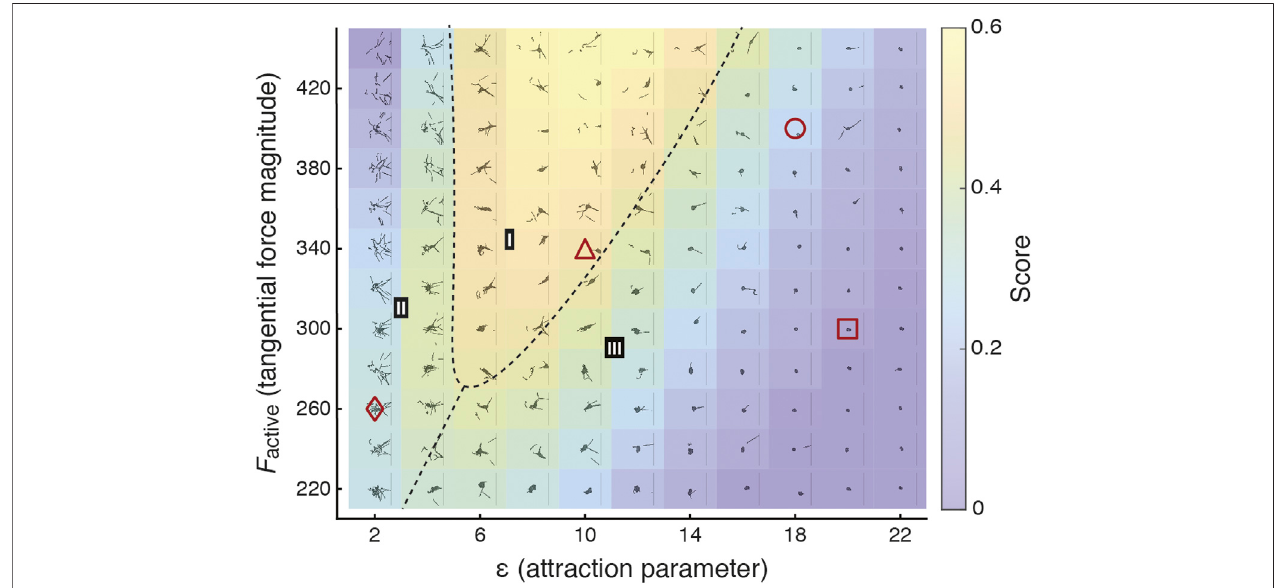
FIGURE5| Heatmapofscorerevealsparameter regimeinwhichthemosteffective collective locomotionisobserved. Thescoreillustratedin Figure4F is fi ttothe function given in Eq. 8 . The heatmap illustrates this fi tted score function and is divided into three regimes (I-III). I: consistently successful cohesive blob locomotion, re fl ectingobservedemergentlocomotioninrealwormblobs( Figure4A );II:generallyunsuccessfulbloblocomotion,withfailureduetodissociationofblobs;III:generally unsuccessful blob locomotion, with failure due to overly strong attachment, resulting in little collective movement. In phases II and III, parameter combinations near theboundaryofphase Icanintermittentlyleadtosuccessful collective locomotion. Eachsubpanel showsanoverlaidsnapshotat between t (cid:1) 50and 150ofanexample simulation with the corresponding F active and ε blob . Red shapes correspond to example sequences shown in Figure 4B .